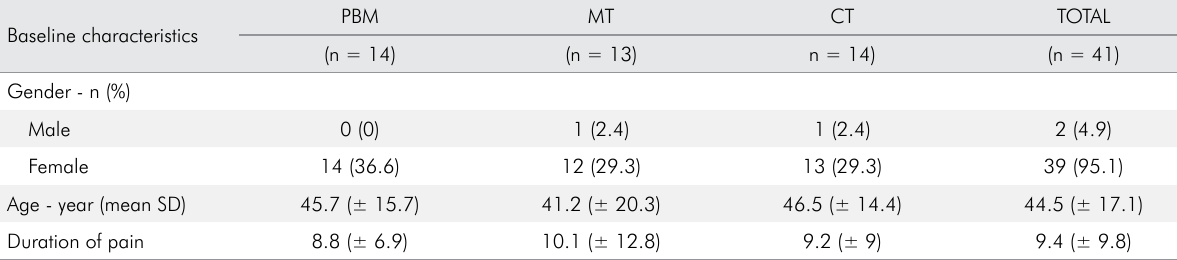
Table 1. General characteristics of patients at baseline. Baseline